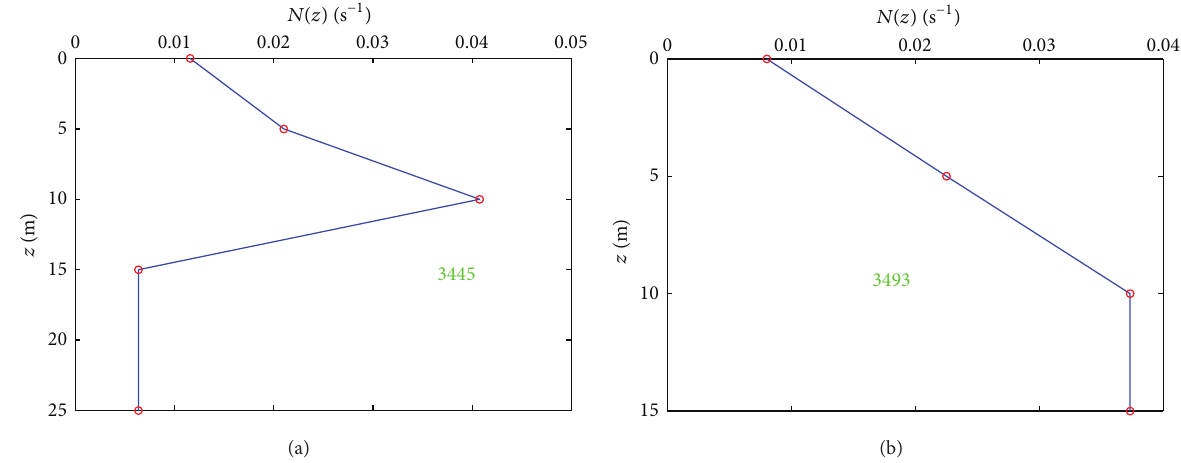
Figure 2: Buoyancy frequency profiles in the Pechora Sea near the region of observation of internal bore.